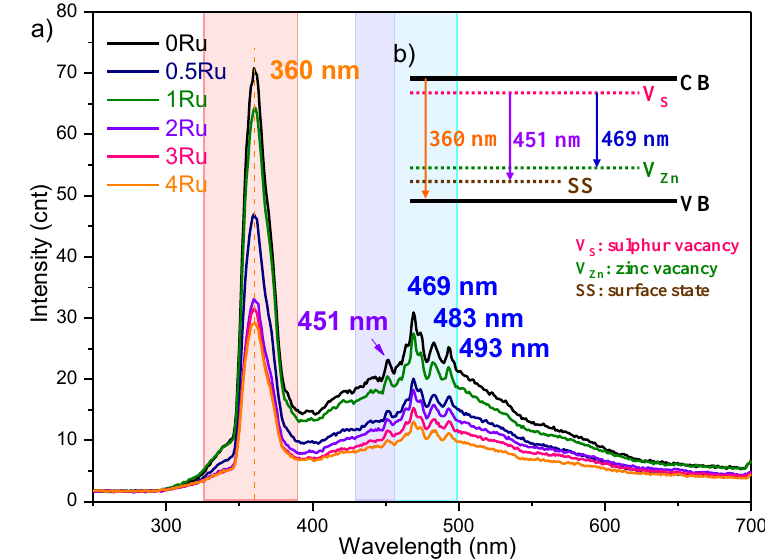
Figure 4. ( a ) PL spectra, and ( b ) energy band diagram of ruthenium-doped CZS/MSG heterostructured photocatalysts.